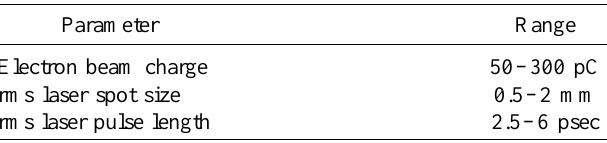
TABLE 1. Electron beam parameter range used for emittance measurements.